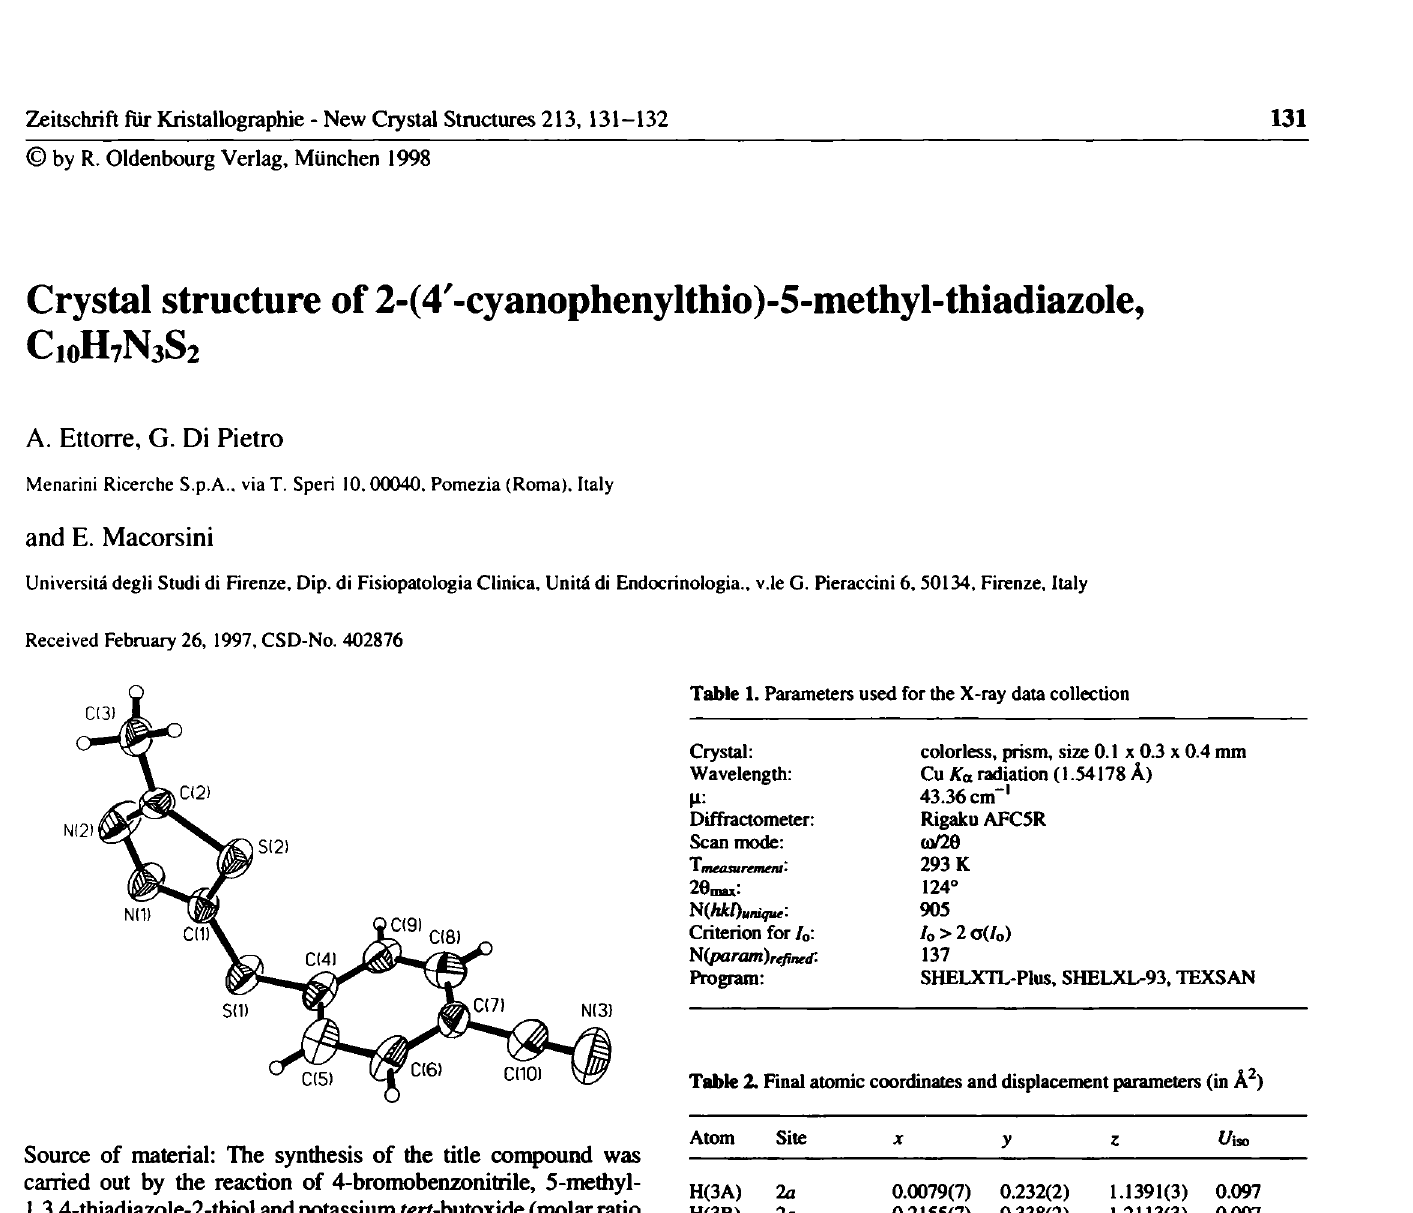
Table 2. Final atomic coordinates and displacement parameters (in